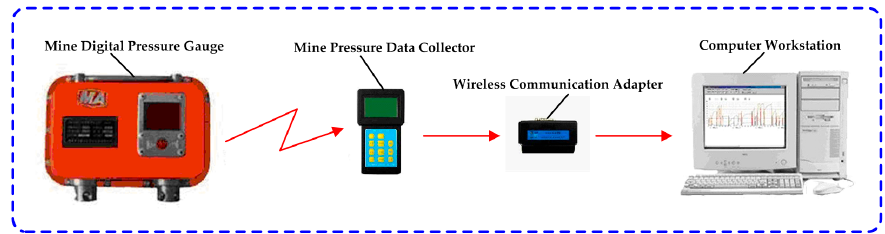
Figure 9. Schematic of the pressure recording system.